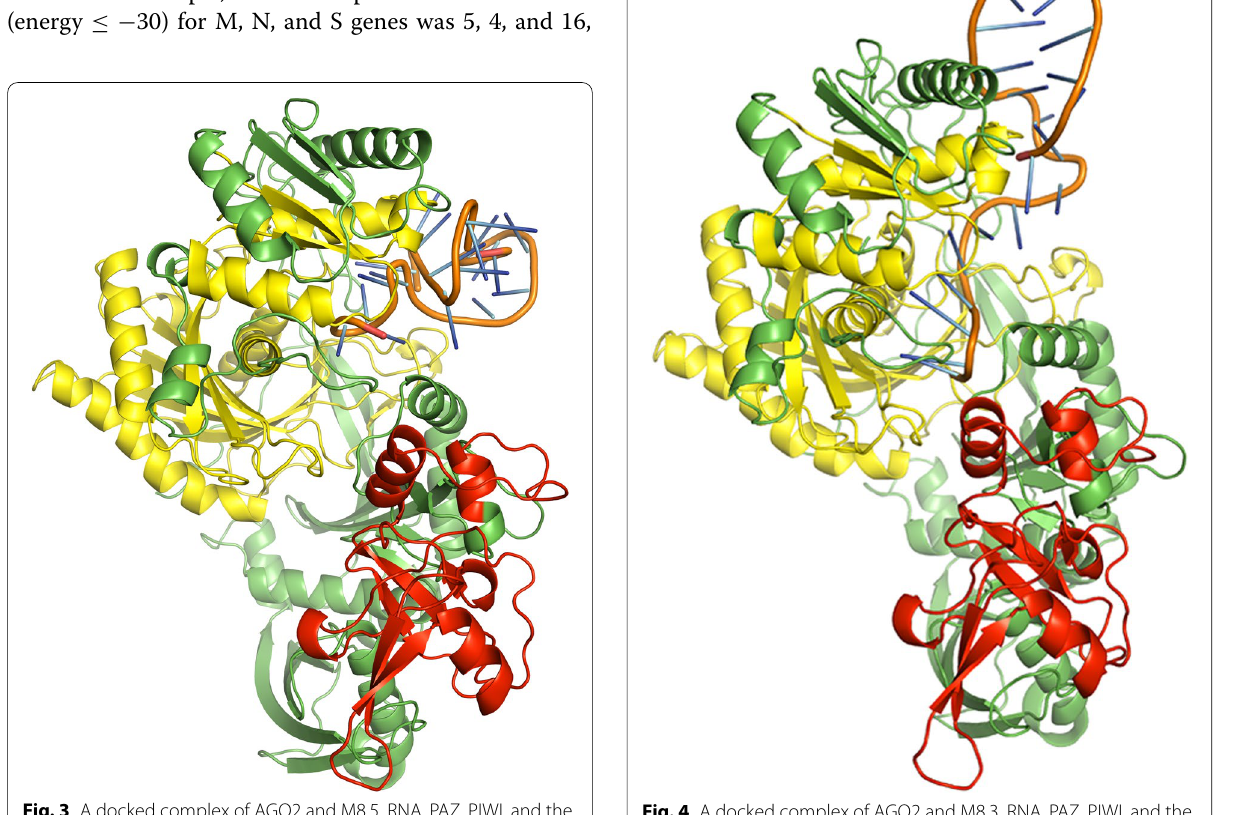
Fig. 4 A docked complex of AGO2 and M8.3. RNA, PAZ, PIWI, and the remaining regions are represented in orange, red, yellow, and green colors,